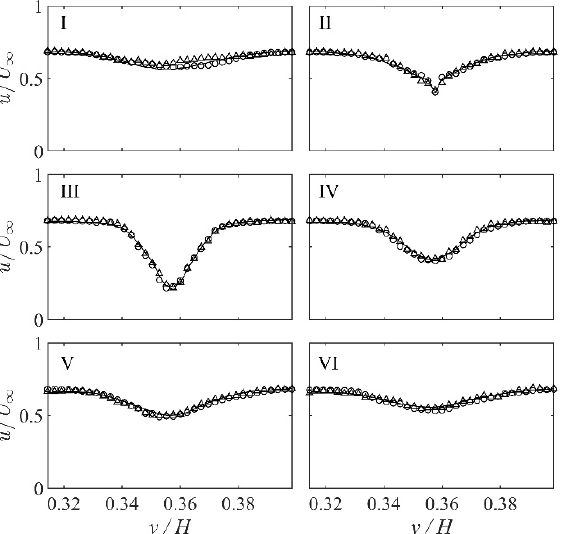
Figure 13. Velocity profiles along the spanwise direction at I, II, III, IV, V, and VI in Figure 11. (–) LES, ( ∆ ) CNN, and ( ◦ ) CNN with data augmentation.